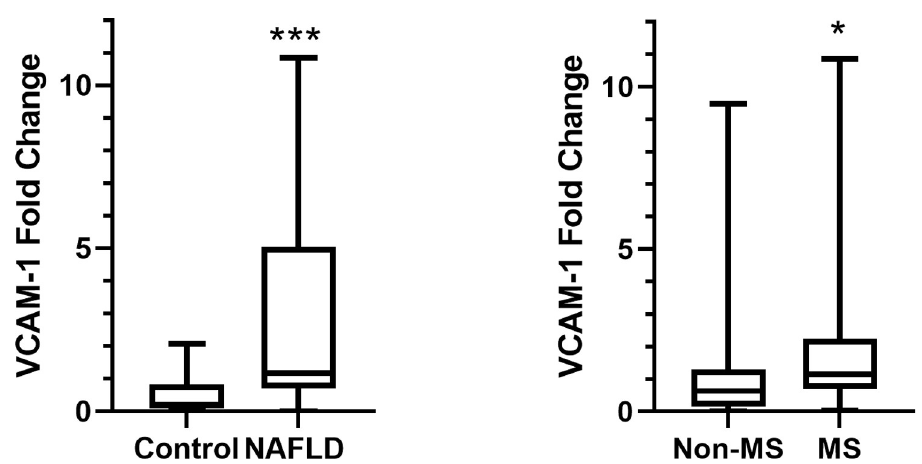
Fig 1. Relative expression of VCAM-1 which indicates anti-inflammatory capacity of HDL. A. The comparison between control and NAFLD groups. B. The comparison between non-MS and MS groups. Differences between the groups were analyzed with Mann-Whitney U; � indicates P <